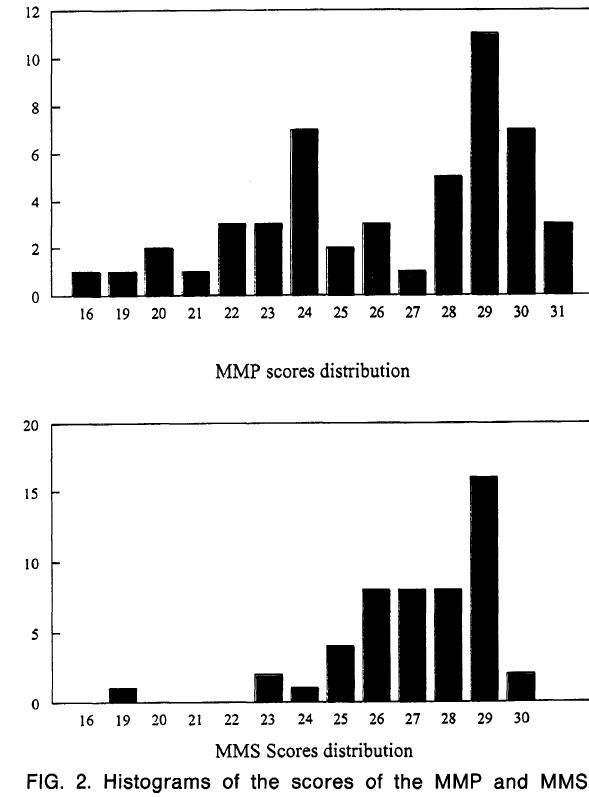
FIG. 2. Histograms of the scores of the MMP and